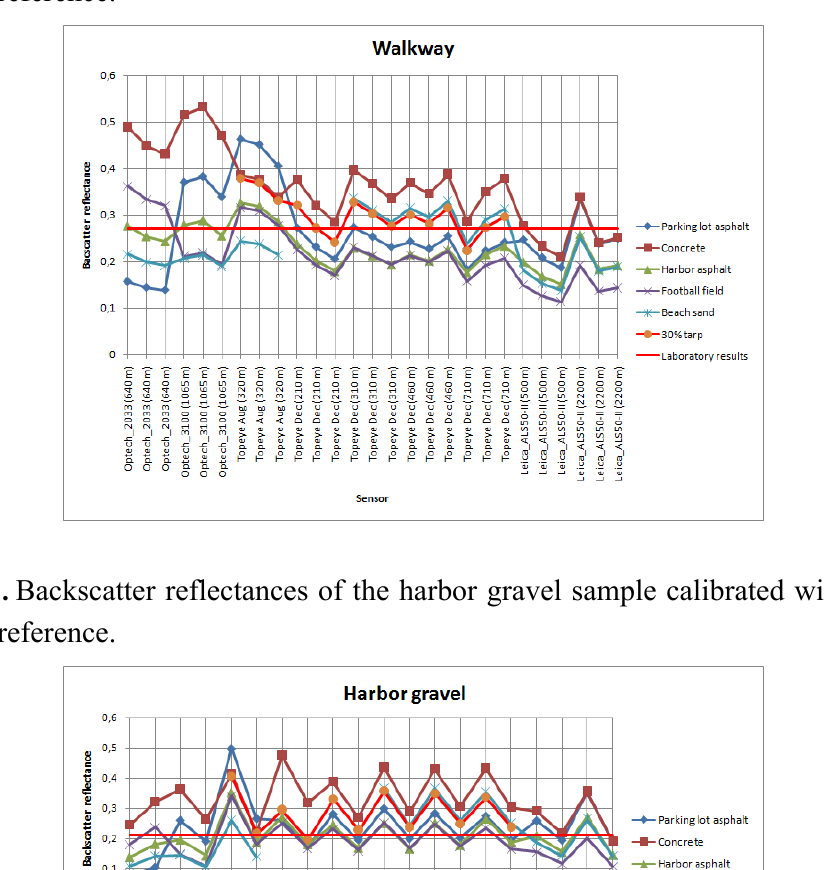
Figure. 7A. Backscatter reflectances of the walkway sample calibrated with different samples as reference.